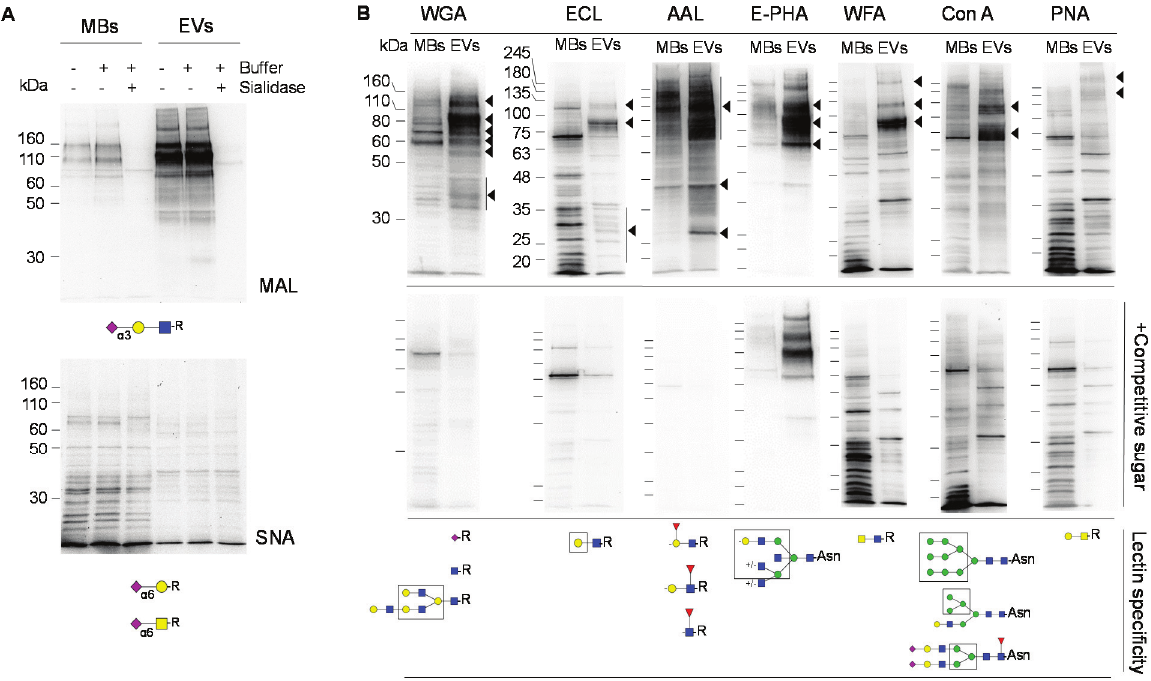
Figure 4. Comparison of glycosignatures from MBs and EVs. A. Lectin blotting with biotinylated MAL and SNA. As control for the lectin blotting the samples were desialylated with sialidase from V. cholerae . B. Lectin blotting with biotinylated WGA, ECL, AAL, E-PHA, WFA, and PNA, and non-biotinylated Con A (upper panels). Controls with competitive sugars as indicated in Material and Methods, are shown in the lower panels. Lectin specificities [28] are shown below the blots. Glycan representation is according to the nomenclature of the Consortium of Functional Glycomics. The lanes contained ten μg of protein. Detection was by the chemiluminescent method. Major specific bands are indicated on the right with arrowheads. The blots are representative of at least three